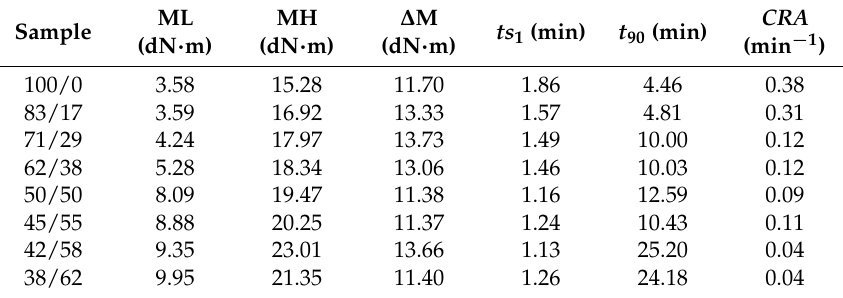
Table 3. Vulcanization characteristics of the analyzed